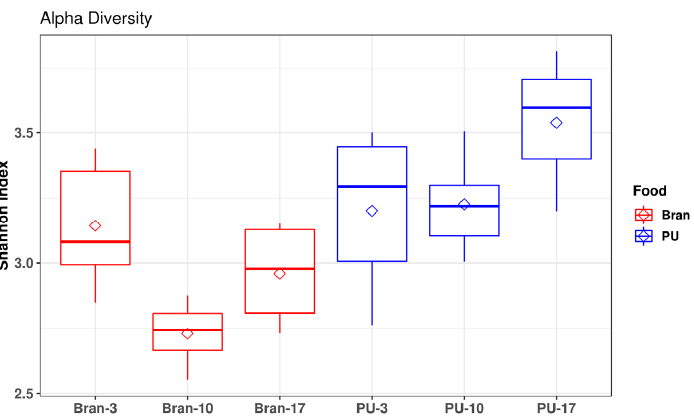
Figure 5. The Shannon diversity index of the gut microbiome of the PU and bran diets throughout the sampling (3, 10, and 17 days).